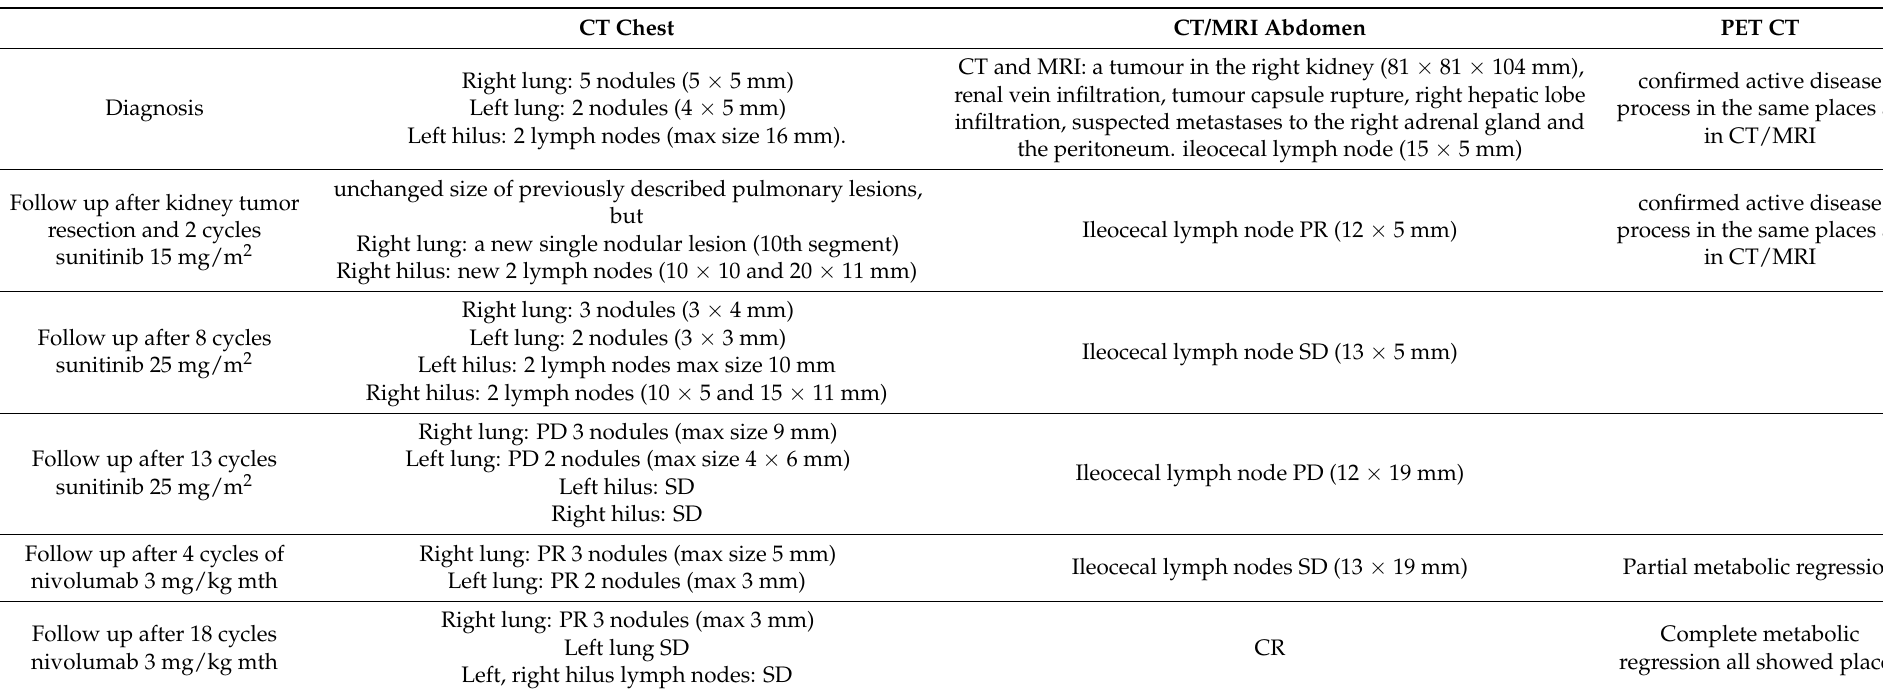
Table 1. Imaging tests (CT, MRI and PET CT) during